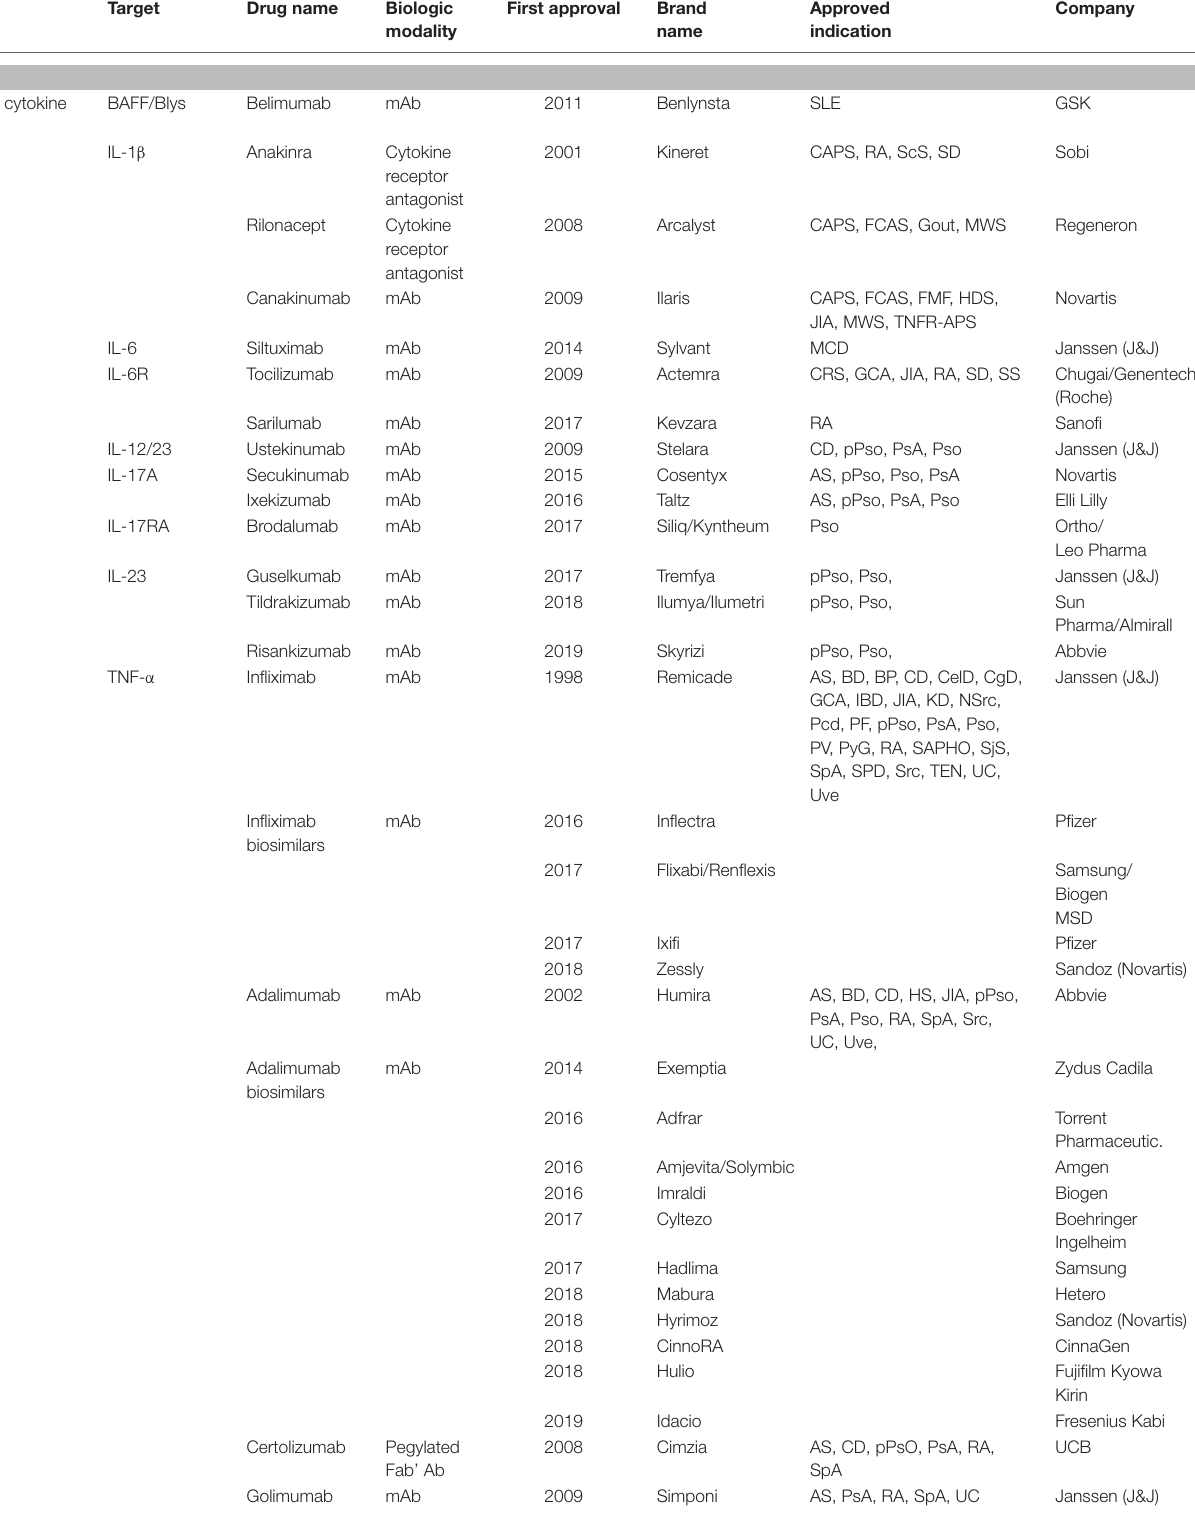
TABLE 1 | Immunotherapy drugs approved for the treatment of autoimmune diseases ◦